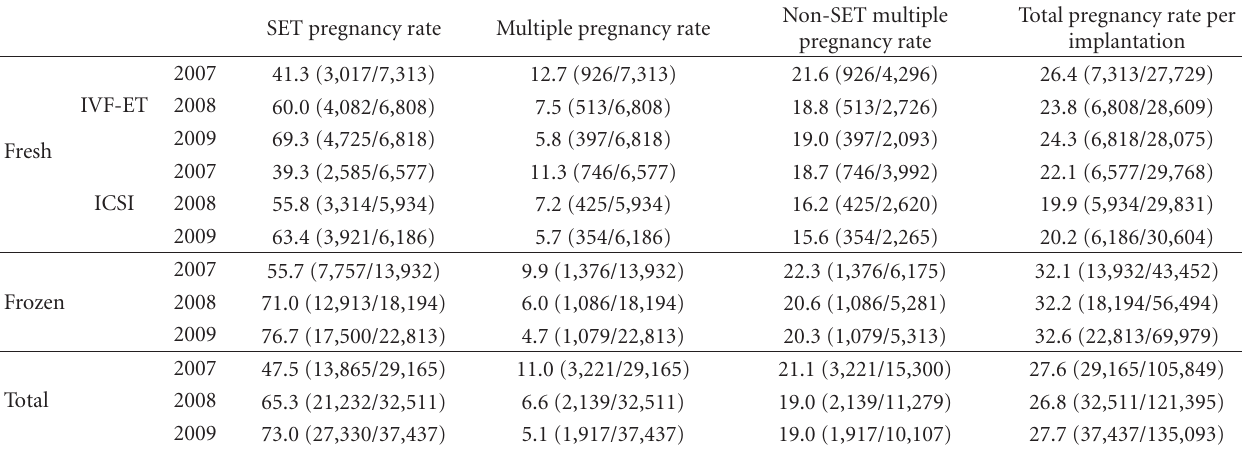
Table 1: SET pregnancy rate, multiple pregnancy rate, non-SET multiple pregnancy rate, and total pregnancy rate according to the ART type.